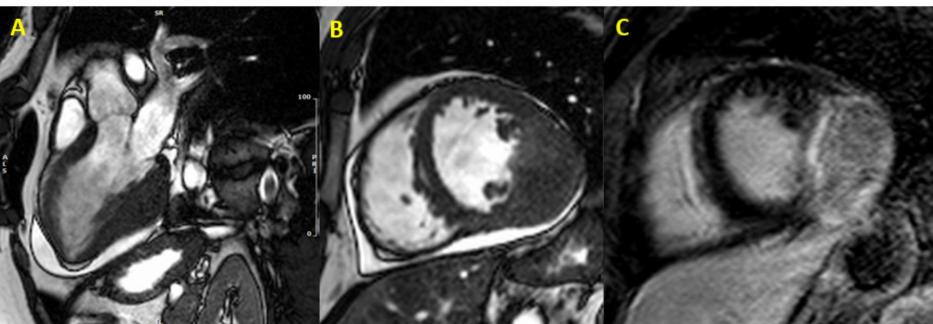
Figure 2. Cardiac fibroma at CMR. Focal myocardial thickening of mid-basal infero-lateral wall, with isointense signal in basal SSFP sequences, mimicking HCM (Panel ( A , B )). Heterogeneous LGE with a capsulated appearance of the focal hypertrophy suggesting cardiac fibroma (Panel ( C )). (CMR = cardiac magnetic resonance; SSFP = steady-state free precession; HCM = hypertrophic cardiomyopathy; LGE = late gadolinium enhancement).